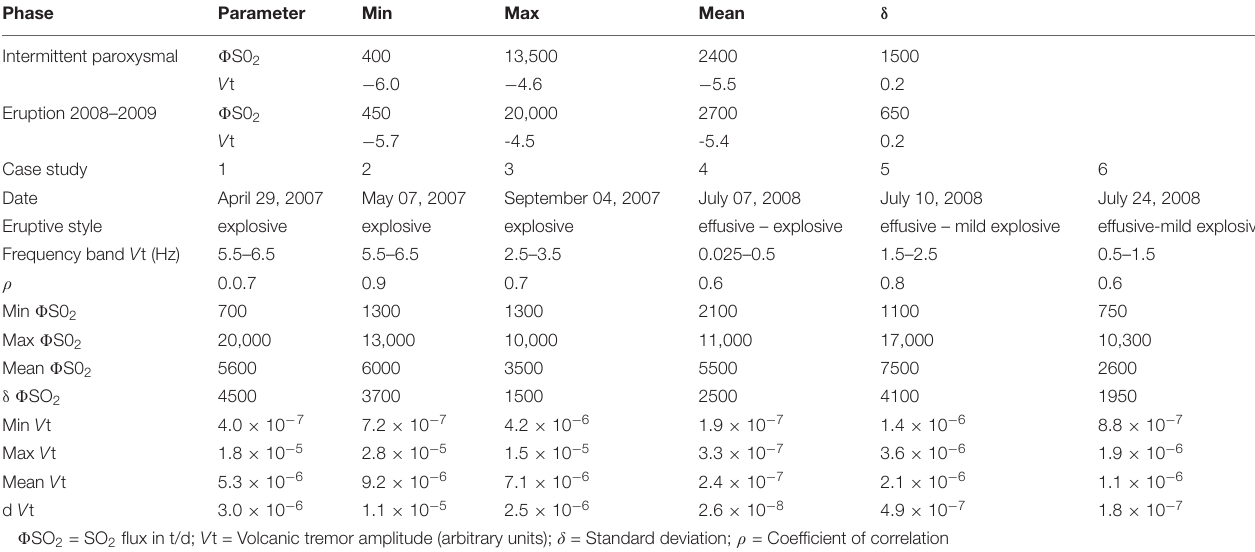
TABLE 1 | Details of the main features and parameters of the intermittent paroxysmal and eruptive 2008–2009 phases and of the six case studies investigated. Phase